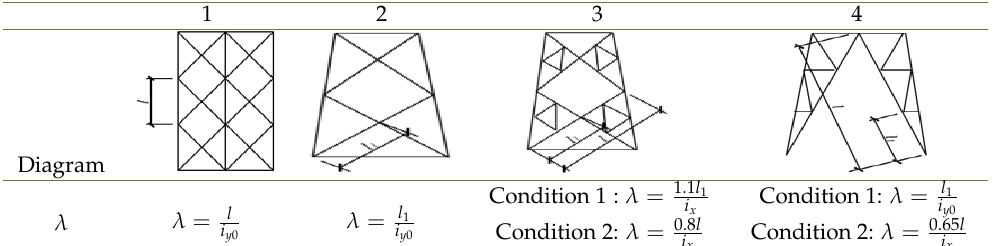
Table 6. Slenderness ratio calculation formulas